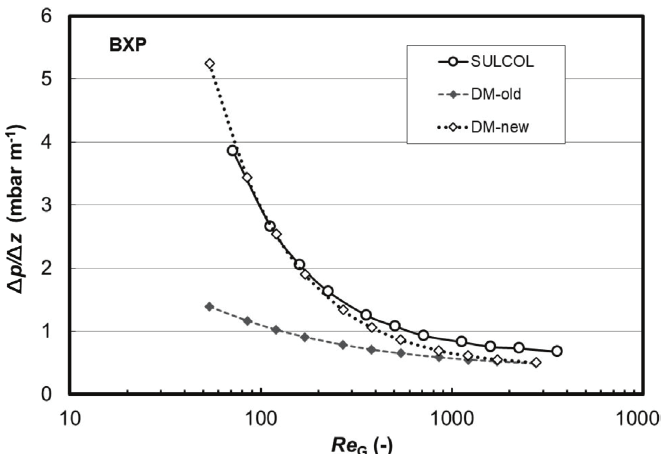
Fig. 11 – Specific pressure drop as estimated by original (DM-old) and extended DM (DM-new) for advanced wire gauze corrugated sheet structured packing (BXP) in conjunc- tion with given hypothetical base case, compared with SUL- COL estimates for